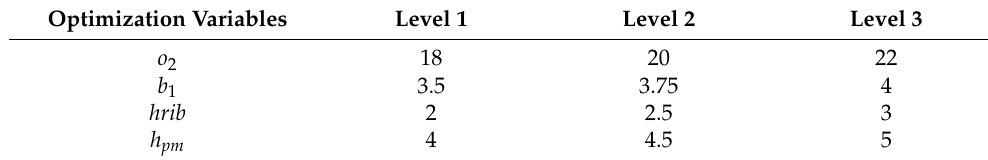
Table 6. Level values of optimization variables.